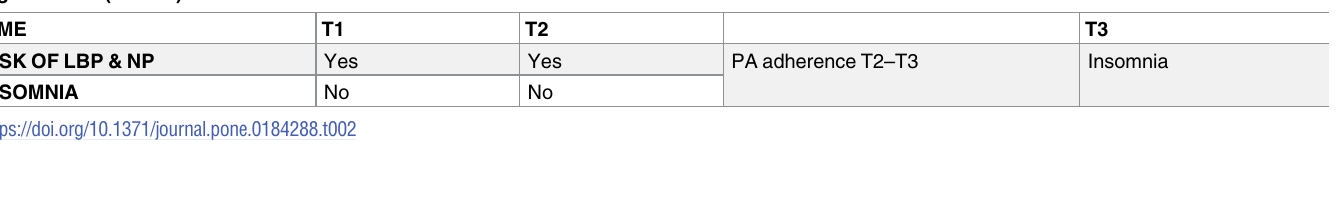
individuals with persistent insomnia, we chose to examine only those individuals without any